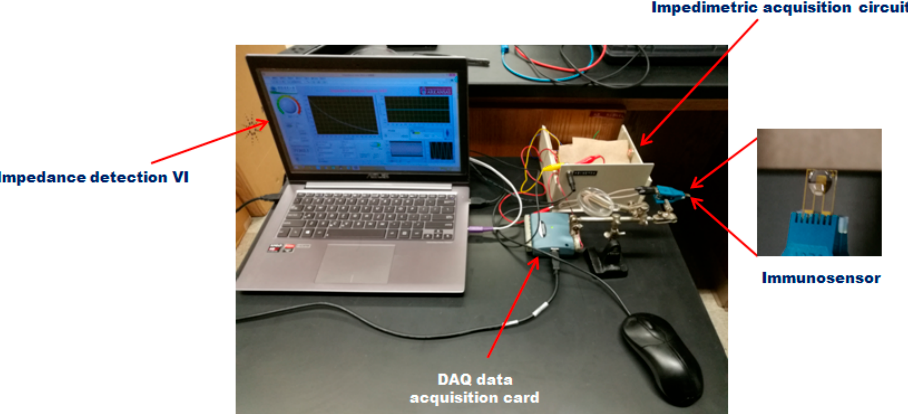
Figure 3 . Setup of the portable impedance immunosensing system. Figure 3. Setup of the portable impedance immunosensing